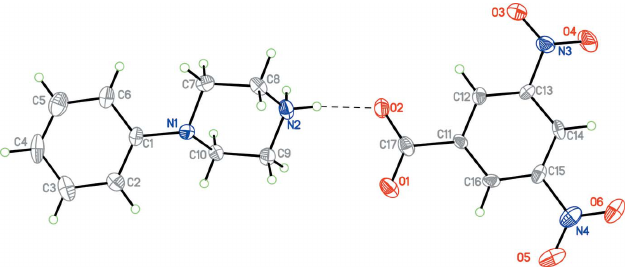
Figure 6 The molecular structure of 7 with hydrogen bonds shown as dashed lines. Atomic displacement parameters are at the 30% probability level.